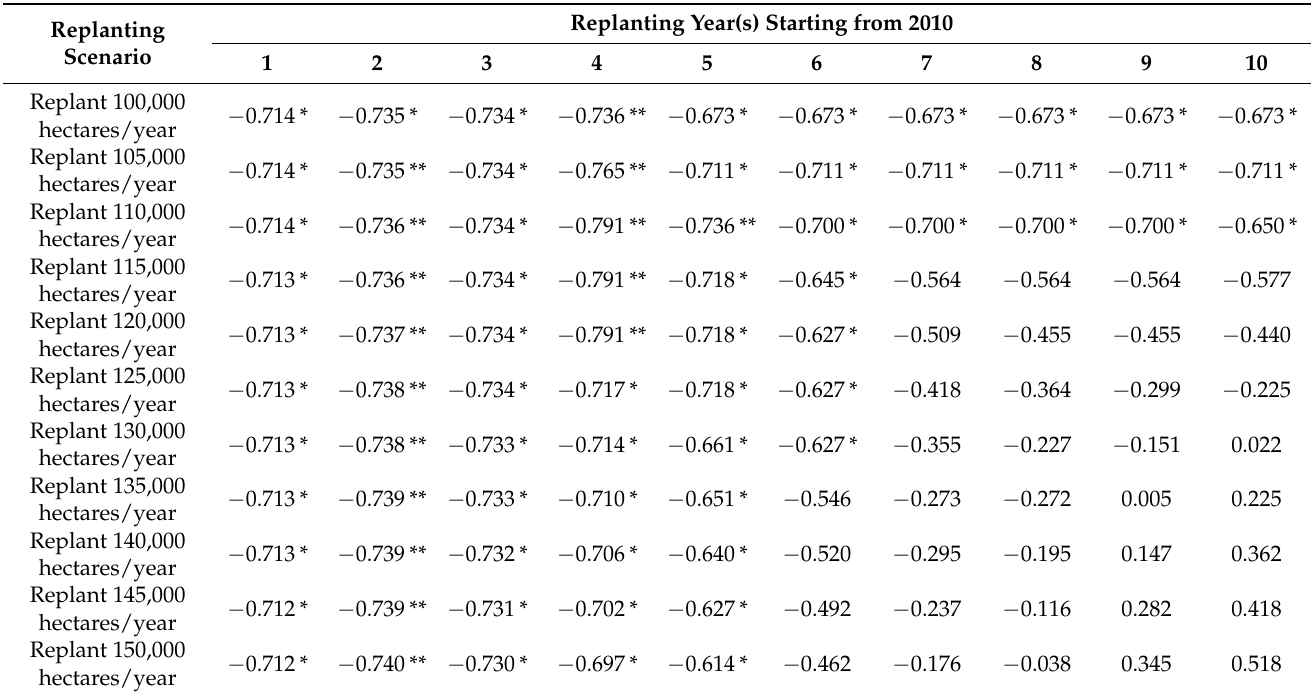
Table A1. Correlations between aged area and FFB yield from 2009 to 2019 for multiple replanting